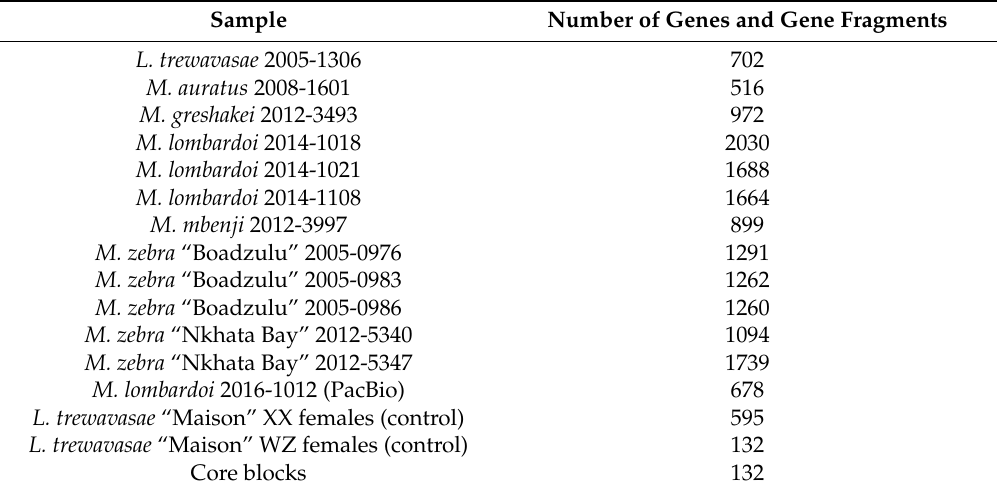
Table 4. Genes and gene fragments on the B chromosome.